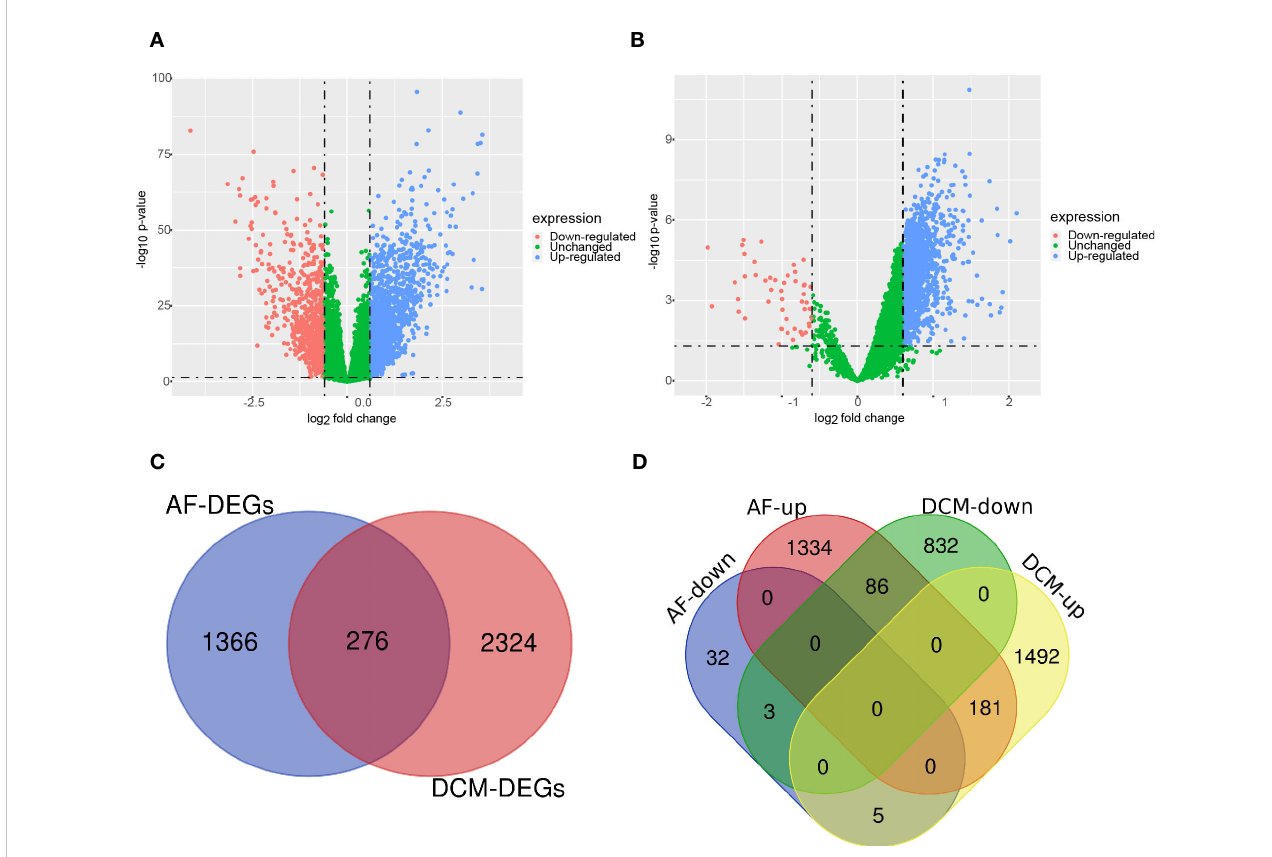
FIGURE 2 Volcano diagram and Venn diagram. (A) The volcano map of GSE141910 (DCM). (B) The volcano map of GSE41177 and GSE79768 (AF). Downregulated genes are marked in light red; upregulated genes are marked in light blue. (C) The DCM and AF datasets showed an overlap of 276 DEGs. (D) 184 DEGs were obtained after excluding genes with opposite expression